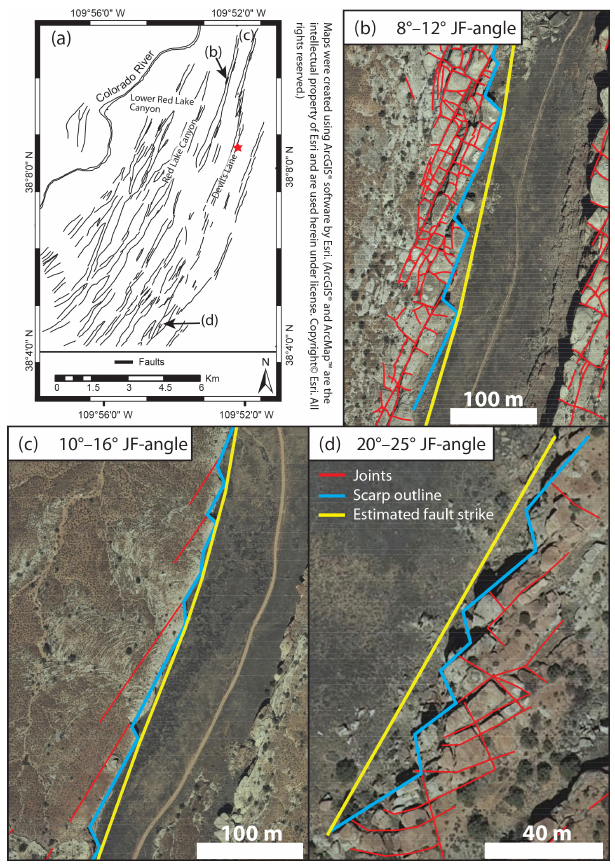
Figure 14. Collection of airborne photographs with interpretations of joints (red), estimated fault strike (yellow) and scarp outline (blue) of selected areas in Canyonlands National Park. (a) Fault map of the grabens of Canyonlands National Park. Locations of (b) , (c) and (d) are shown as well as Fig. 15d. North is up in all images. (b) 8–12 ◦ JF-angle. (c) 10–16 ◦ JF-angle. (d) 20–25 ◦ JF-angle.